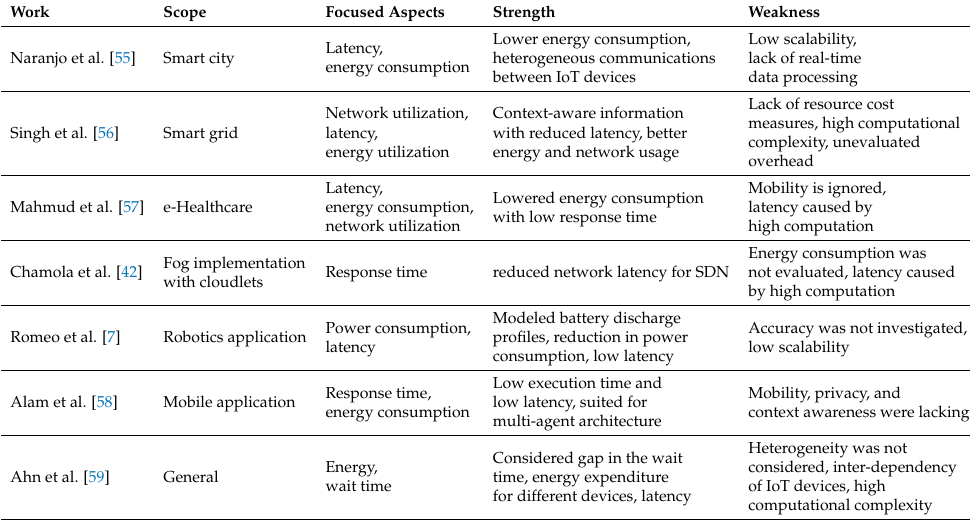
Table 1. Research work on latency sensitivity in different